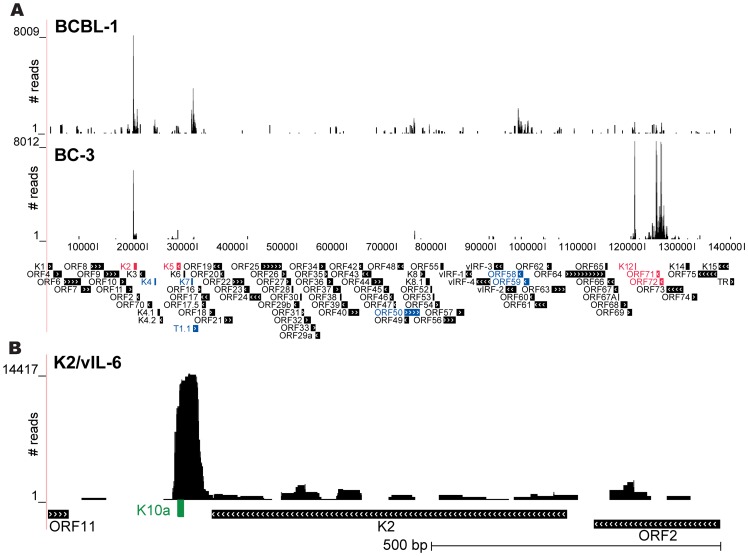
Ago HITS-CLIP clusters on the viral genome.
A: Wiggle plots displaying read clusters across the KSHV genome in BCBL-1 and BC-3 cells. In contrast to BCBL-1, the KSHV genome is barely targeted in BC-3. Common targeted regions are the K2/vIL-6 gene (predominantly its 3′UTR), K5,K12/Kaposin(3′UTR), the miRNA cluster region, ORF71/vFLIP, and ORF72/vCyclin. Reads were recovered at comparable numbers from vIL-6 and K5 in both cell lines, but with a much higher coverage from the other four common loci in BC-3. In BCBL-1 several additional potential target sites were detected (K4, T1.1/PAN, ORF50/RTA, ORF58, and ORF59). Major target sites in both cell lines are marked in red, sites targeted only in BCBL-1 are marked in blue; B: prominent read cluster in the 3′UTR of K2/vIL-6 with a 6-mer miR-K12-10a target site.